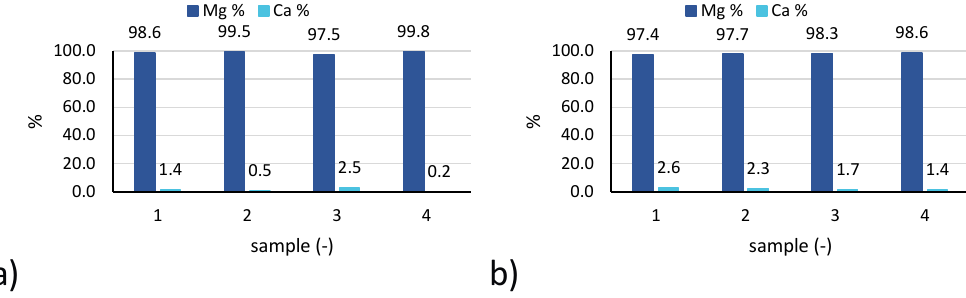
Figure 8. Solid purity expressed as percentage of magnesium and calcium ions in the 4 solid samples collected during: ( a ) test 3; ( b ) test 6.